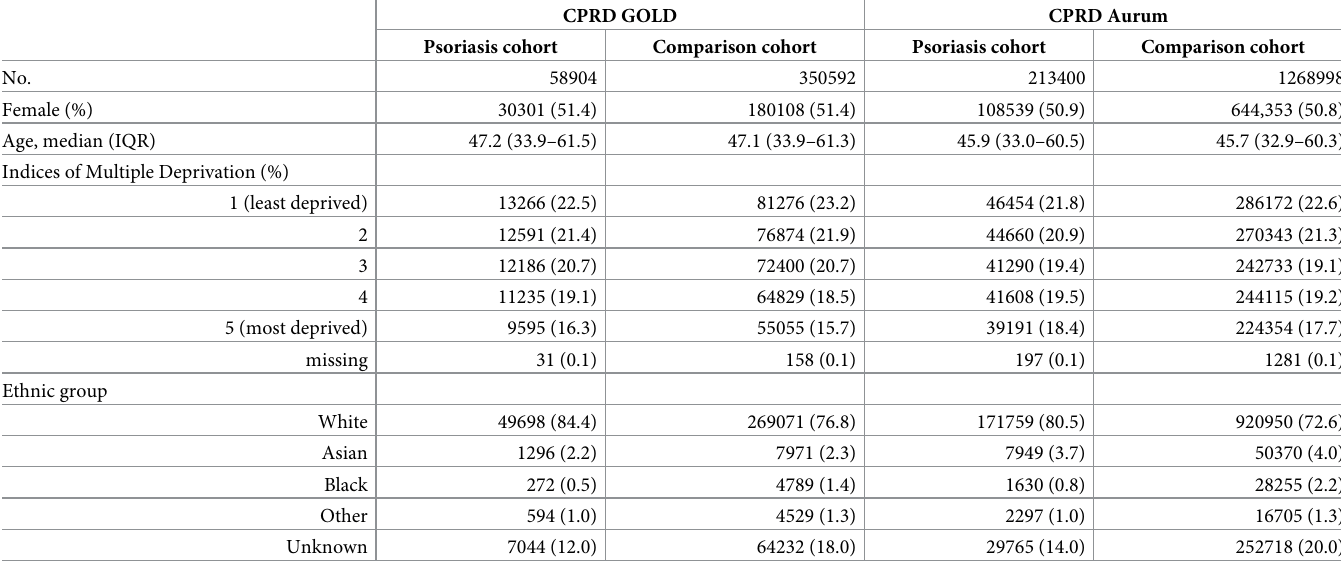
Table 1. Demographic characteristics of psoriasis and comparison cohorts.